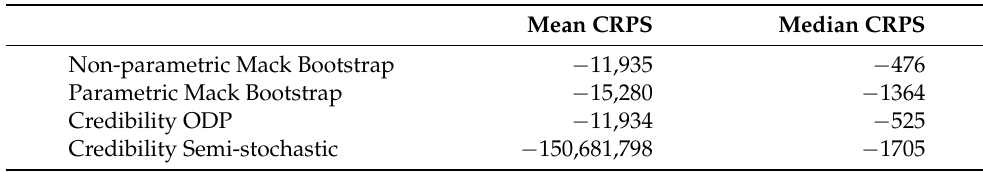
Table 2. Mean and median CRPS